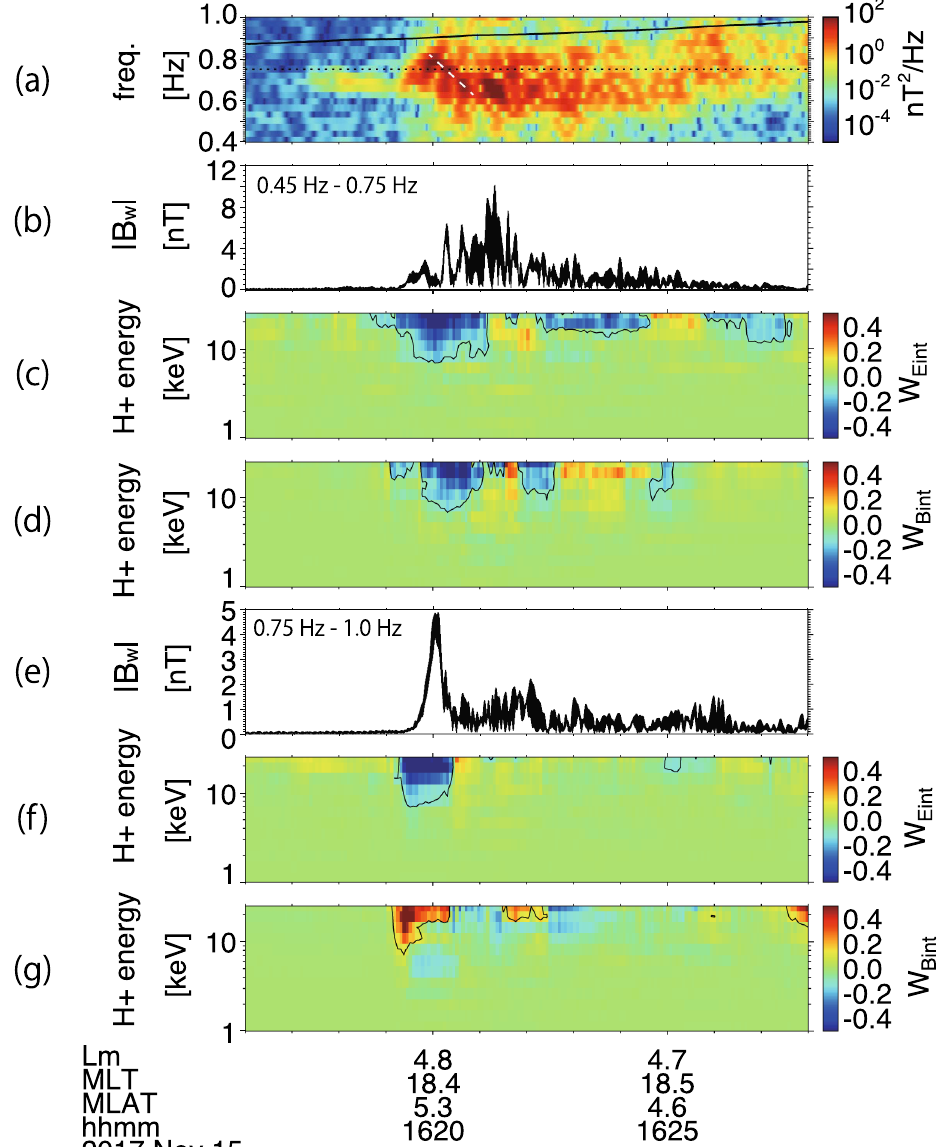
Figure 3. ( a ) Dynamic spectrum of the magnetic field in the spin axis direction. The black line indicates the helium cyclotron frequency. The white dashed line shows the estimated frequency sweep rate. ( b , c , d ) Magnetic field wave amplitude, W Eint , and W Bint calculated with the electromagnetic field bandpass filtered between 0.45 and 0.75 Hz (shown by dotted line), respectively. Black curves show the contour with the values = − 0.1. ( e – g ) Magnetic field wave amplitude, W Eint , and W Bint calculated with the electromagnetic field bandpass filtered between 0.75 and 1.0 Hz, respectively. Black curves show the contour with the values W Eint = − 0.1 , and W Bint = 0.1 . The WPIA results, W Eint , and W Bint , have been calculated with protons of pitch angle between 125° and 145° (Created by using IDL 8.8 https:// www. l3har risge ospat ial. com/ Softw are- Techn ology/